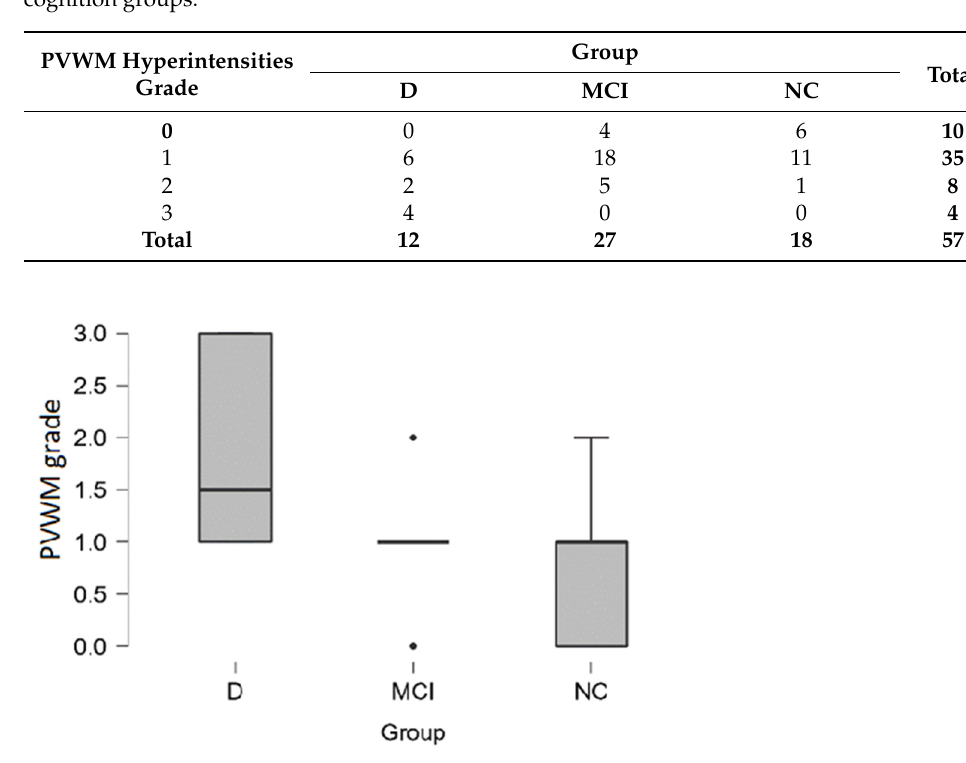
Figure 7. PVWM hyperintensities grade boxplot in (from left to right) dementia, MCI, and normal cognition groups (black dot–outlier).